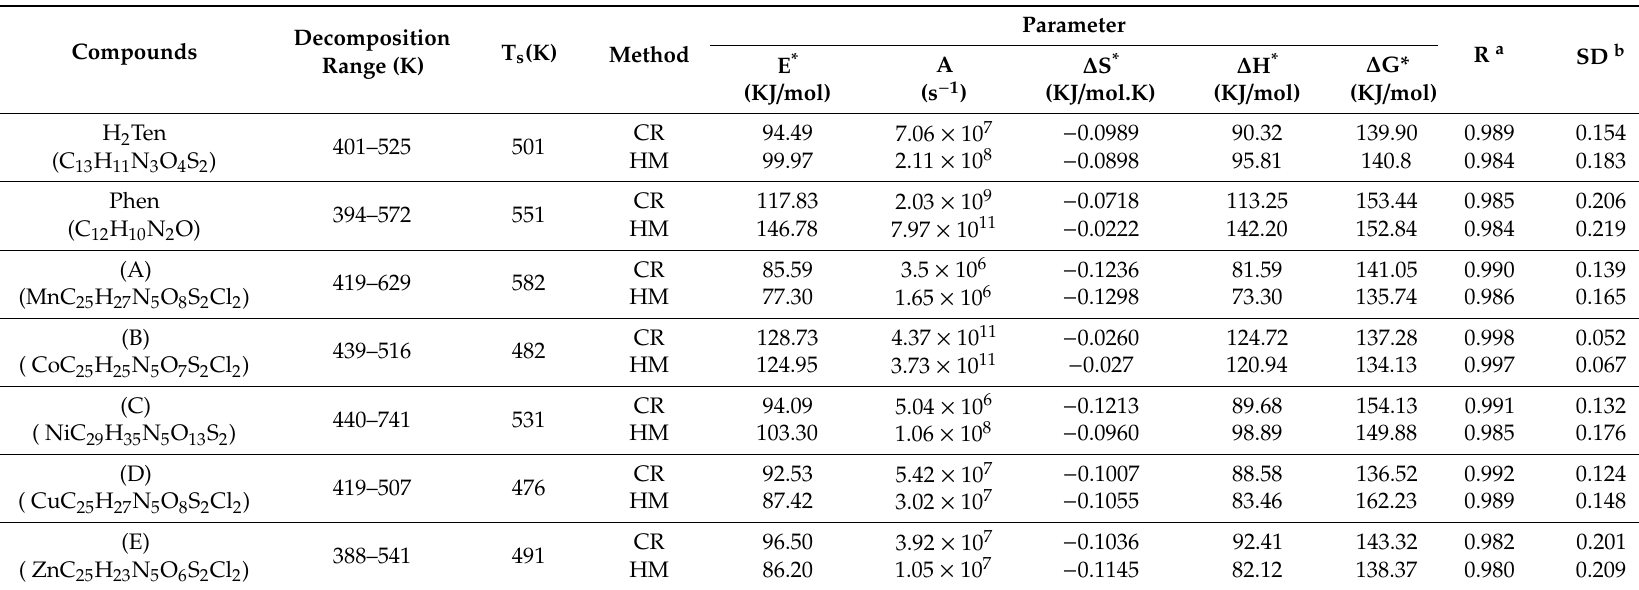
a: correlation coe ffi cients of the Arrhenius plots. b: standard